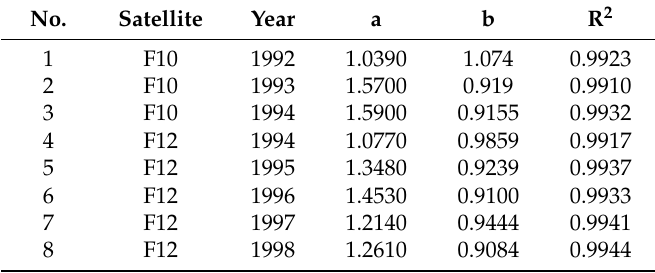
Table A1. Intercalibration model coefficients of each